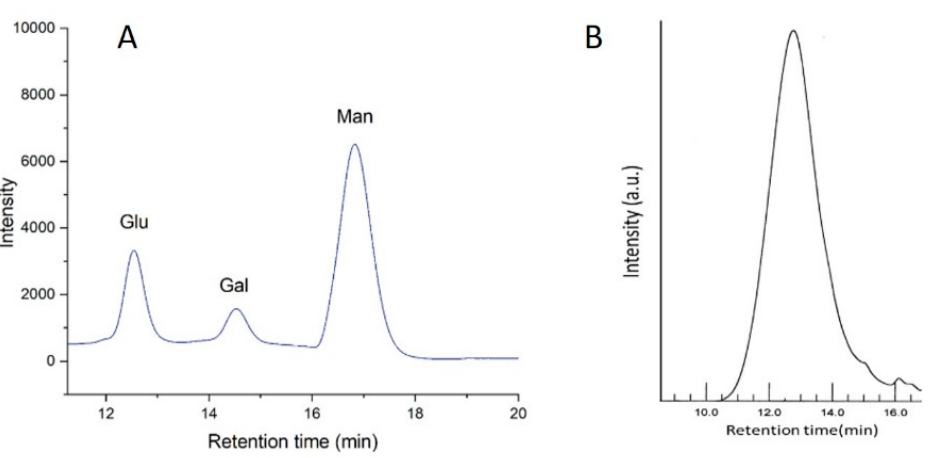
Figure 5. ( A ) HPLC analysis of the constituting monosaccharides, and ( B ) GPC analysis of the EPS. In Figure 5B the GPC chromatogram of CamB6 EPS is presented and shows a broad